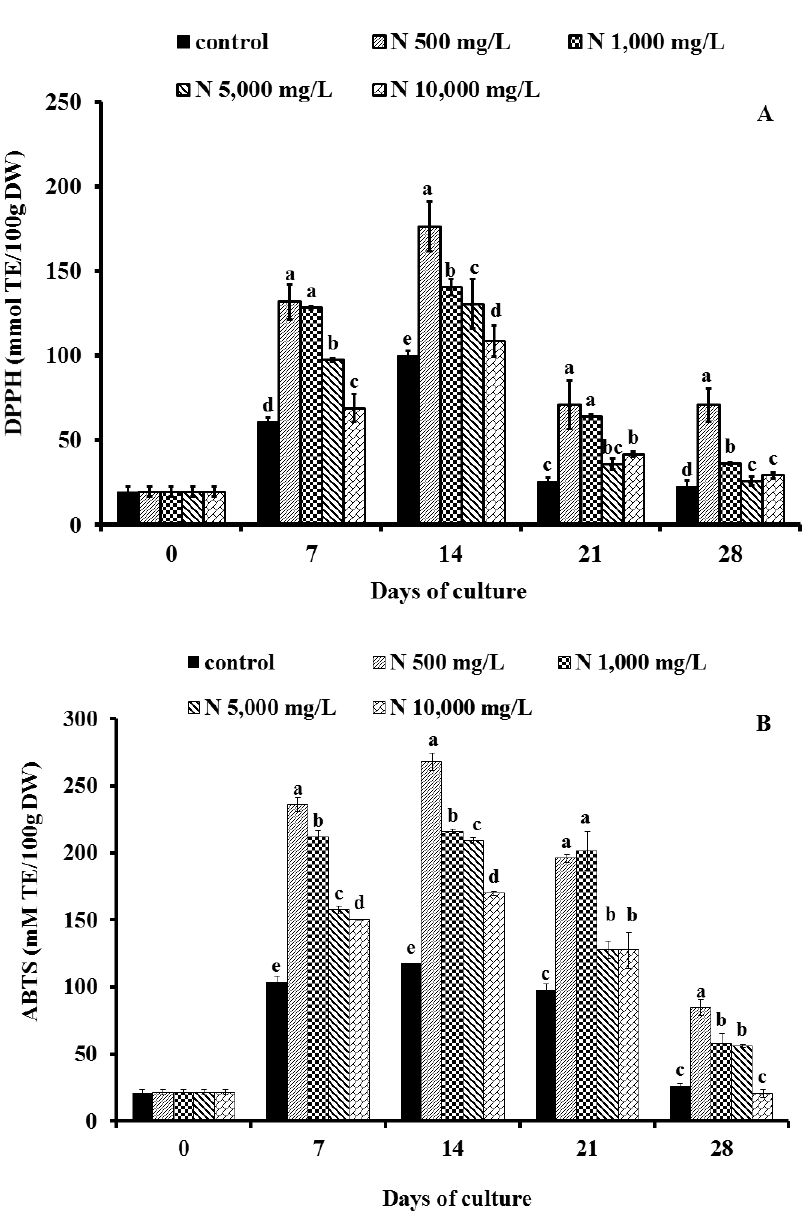
Figure 5. Effect of ammonium nitrate (control, N 500 mg/L, N 1,000 mg/L, N 5,000 mg/L and N 10,000 mg/L) on antioxidant activity measured by DPPH • ( A ) and ABTS •+ ( B ) expressed in Trolox equivalents (mmol TE/100 g DW) of ‘Pok Dum’ Vitis vinifera cell suspension cultures. Data are mean ± SD ( n = 3). Means at each day of culture with the same letter do not differ according to Duncan’s New Multiple Range Test, p ≤